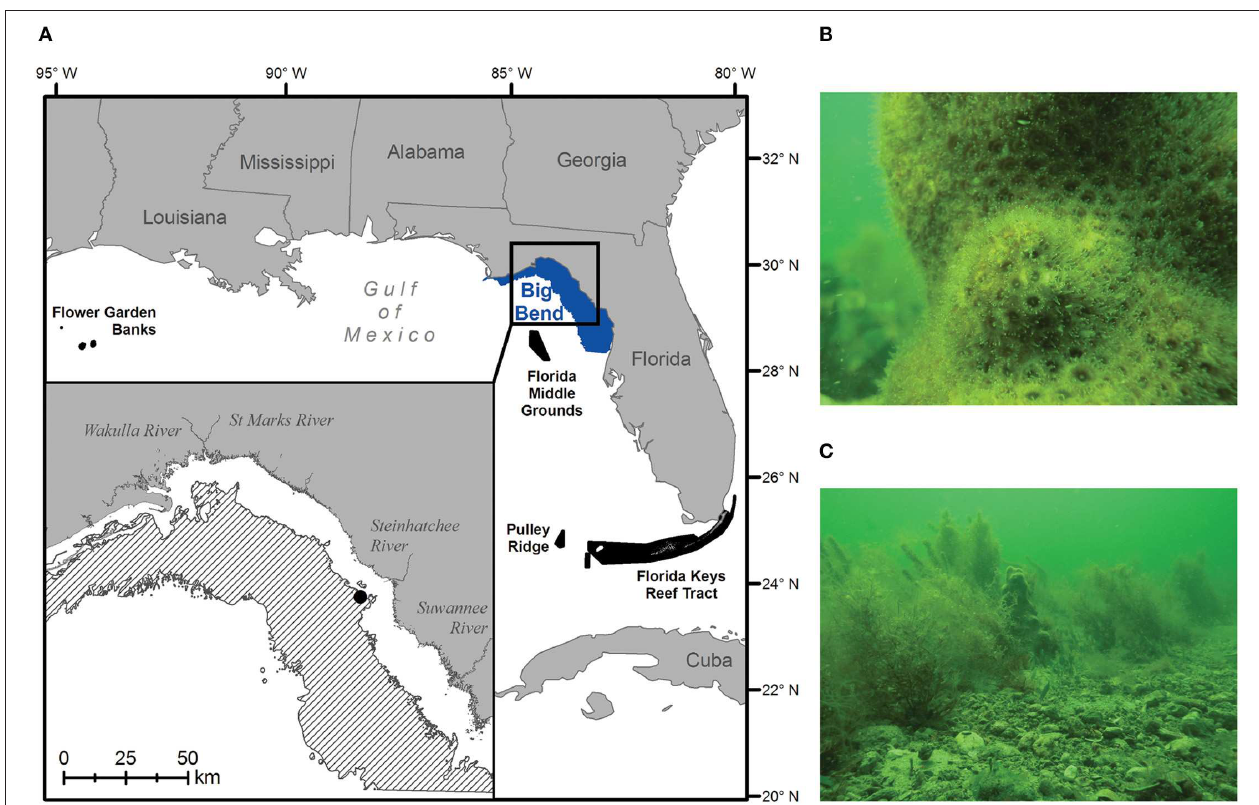
FIGURE 1 | The 0–20m ( A : blue polygon) and 5.5–18m ( A inset: black diagonal bars) depth bands of Big Bend region of Florida, USA in the northern Gulf of Mexico. Black polygons denote potential larval sources of hermatypic coral species to the area—in decreasing order of importance: the Florida Middle Grounds, Pulley Ridge, Florida Keys Reef Tract, and the Flower Garden Banks. Scenes of current hard-bottom communities dominated by (B) cold-tolerant scleractinian corals (shown: Solenastrea sp.), and (C) soft corals and attached macroalgae (shown: Sargassum sp. and Caulerpa spp.), were taken at 6.7 m depth off Steinhatchee, Florida on April 13, 2018 ( A inset; black